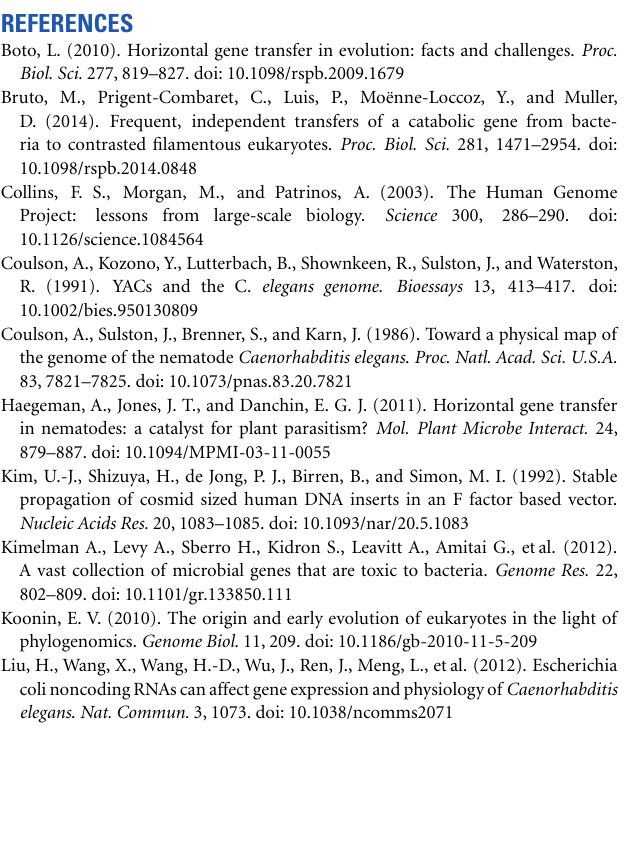
Table S1 | RepeatMasker results for the various groups of clones, averaged per clone for each clone type. Table S2 | RepeatMasker results for the various groups of clones, median per clone for each clone type. Table S3 | RepeatMasker results for the various groups of clones, summed per clone for each clone type. Table S4 | RepeatMasker results for the various groups of clones, number of clones for each clone type that are non-zero. Table S5 | RepeatMasker results for the various groups of clones, the minimal result per clone for each clone type and the clones with that value. Table S6 | RepeatMasker results for the various groups of clones, the maximal result per clone for each clone type and the clones with that value. Table S7 | RepeatMasker results for the randomly-selected genomic segments with the same size distributions asYACs, cosmids, and fosmids (averaged per segment for each clone